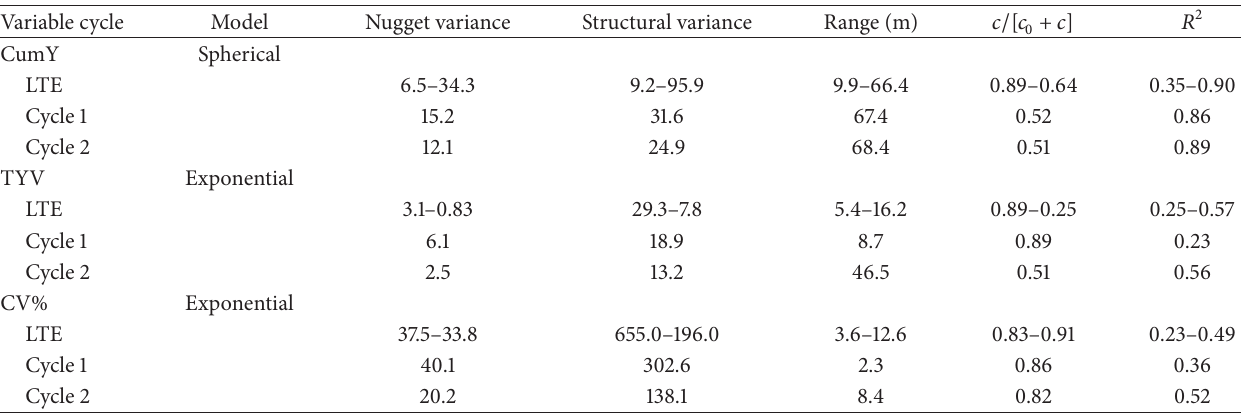
Table 2: Summary of model statistics for cumulative yield, CumY, temporal yield variance, TYV, and coefficient of variation, CV, for a long- term experiment in each of the two cycles of a long-term experiment